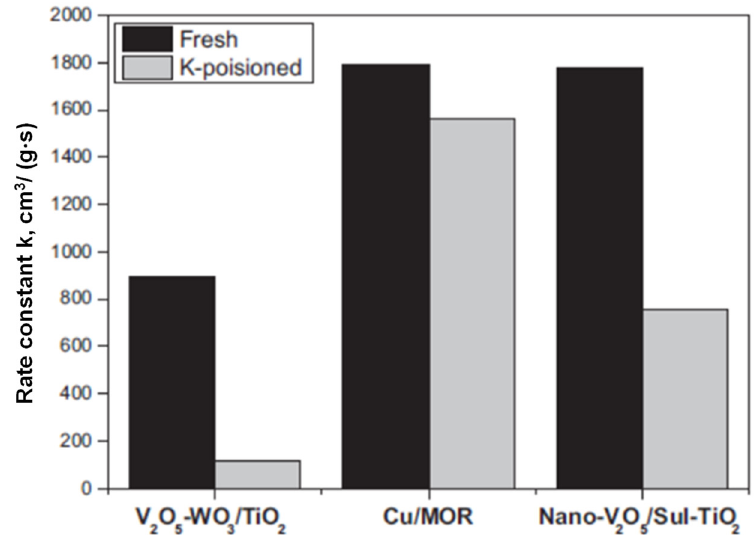
Figure 7. The deNO x rate constant values at 400 °C over alternative SCR catalysts with high potassium loading: 250 µ mol K / g for V 2 O 5 -WO 3 / TiO 2 and Cu / MOR, and 280 µ mol K / g for Nano-V 2 O 5 / Sul-TiO 2 . Reproduced from Reference [19].